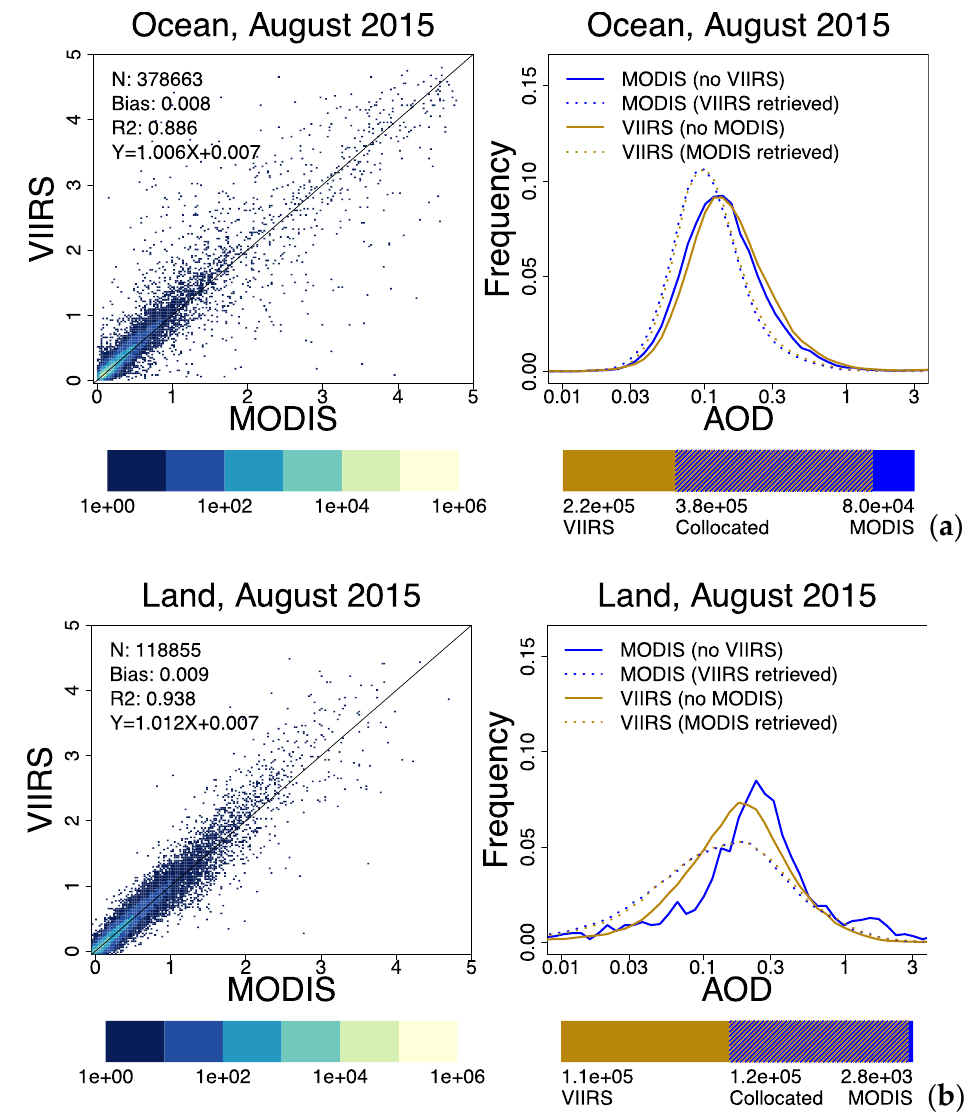
Figure 9. Comparison of all 0.55 µ m AOD daily average one-degree grid cells from August 2015. Left, scatterplots of collocated MODIS Aqua and VIIRS SNPP cells; right, histogram frequencies where MODIS and VIIRS were collocated (dotted lines) and where only one sensor retrieved AOD (solid lines). The horizontal bar on the right indicates the number of collocated and non-collocated grid cells for each sensor. AOD values are ( a ) over ocean and ( b ) over land.